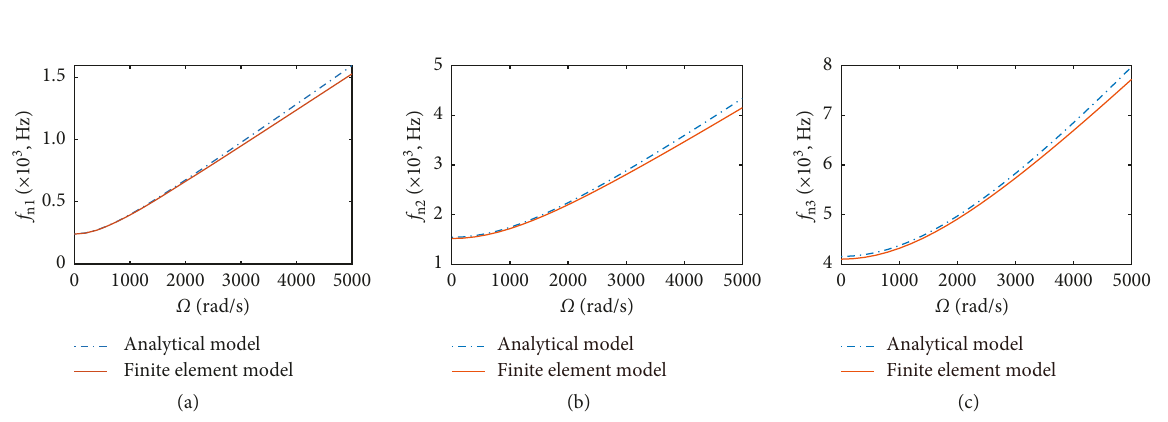
Figure 3: Dynamic frequencies obtained from FE model and analytical model.